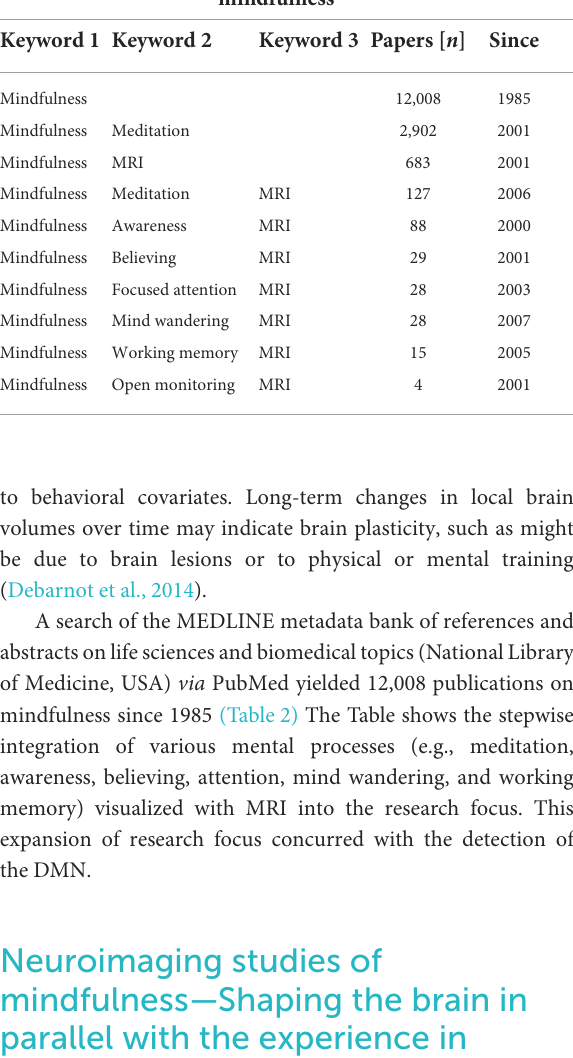
TABLE 2 Literature search in PubMed [National Library of Medicine, USA]. Assimilation of new settings into the context